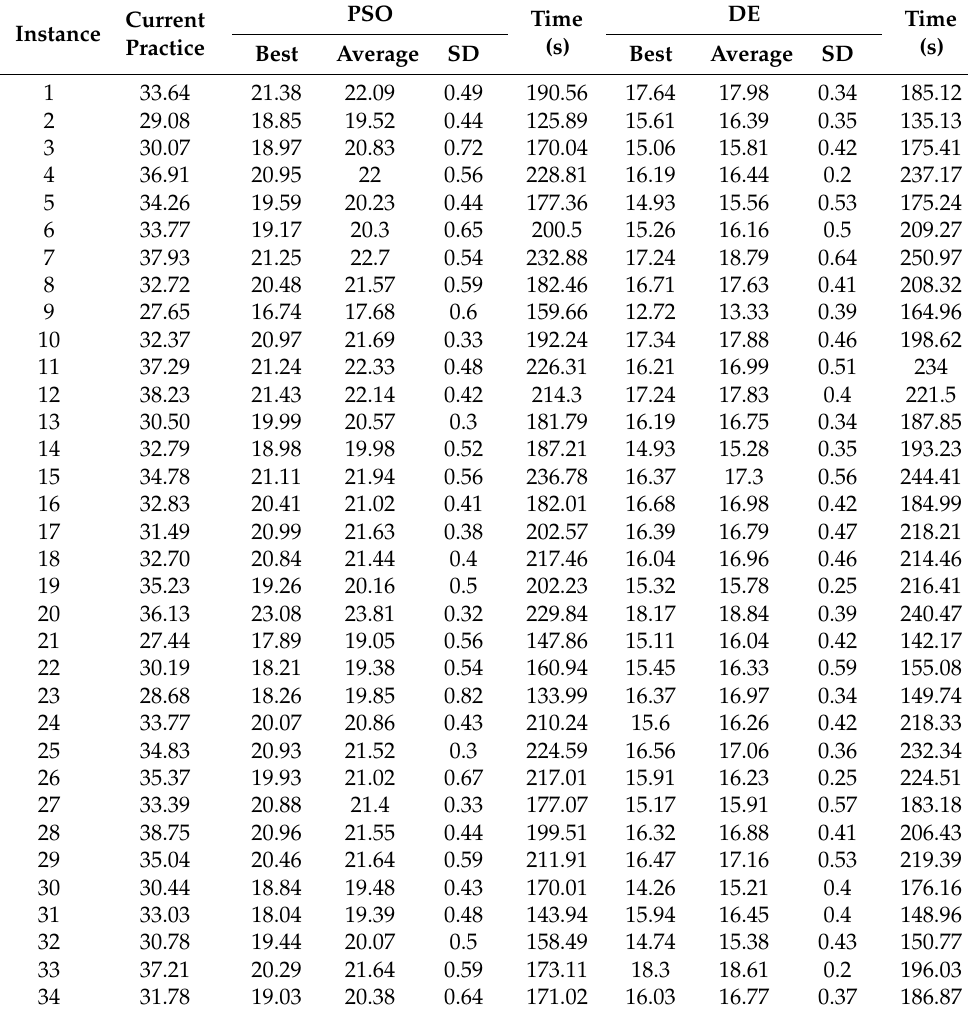
Table 3. Experimental results of total